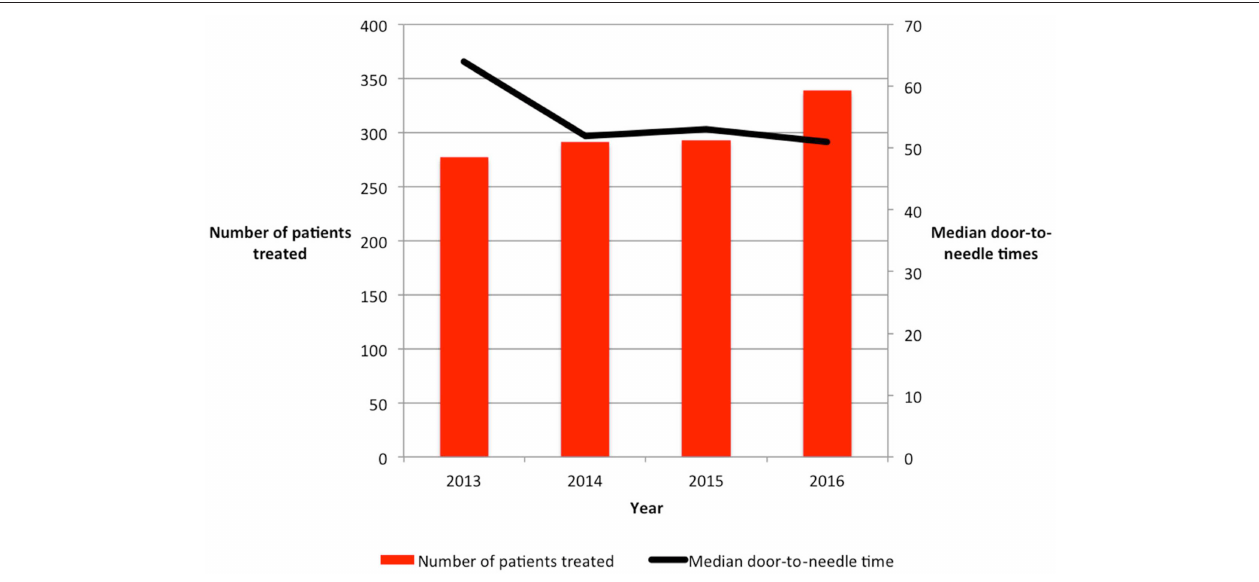
FIGURE 1 | Annual number of patients with acute ischemic stroke treated with intravenous thrombolysis and median door-to-needle times in Northern Ireland from 2013 until 2016.